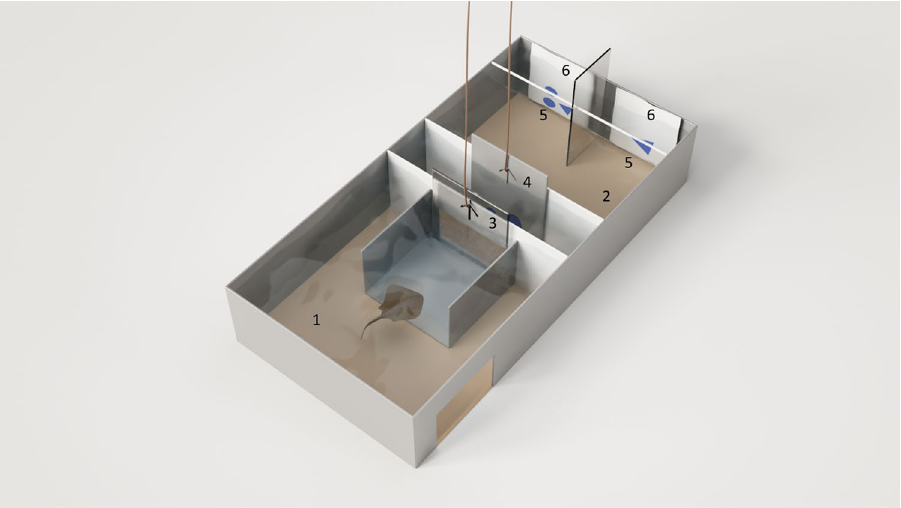
Figure 2. Experimental setup for the stingrays. 1) start box, 2) experimental area, 3) guillotine door, 4) door with test stimulus, 5) decision areas, 6) choice stimulus